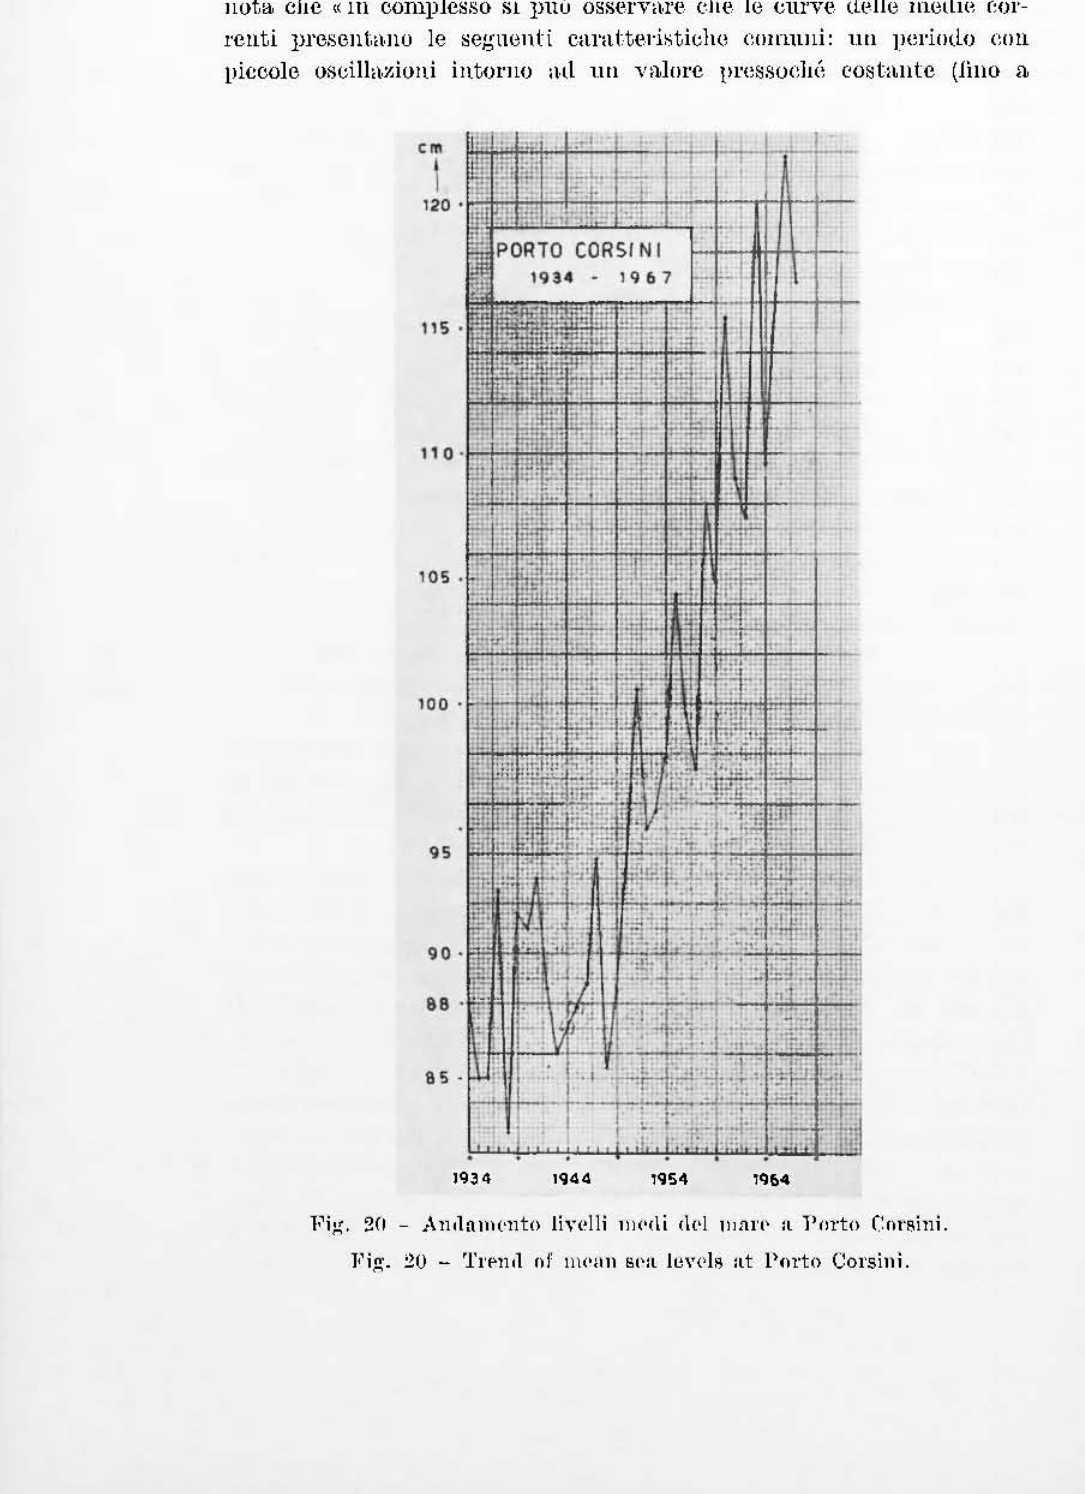
Fig. 20 - An,lalll('nto livelli 11]('(li (!t'l 111'\1'(' a l'ort o Cor~ini. Fip;. 20 - '1'1'1'11,1 or 11]('1111 B('a l(j\'d~ at l'nrt o